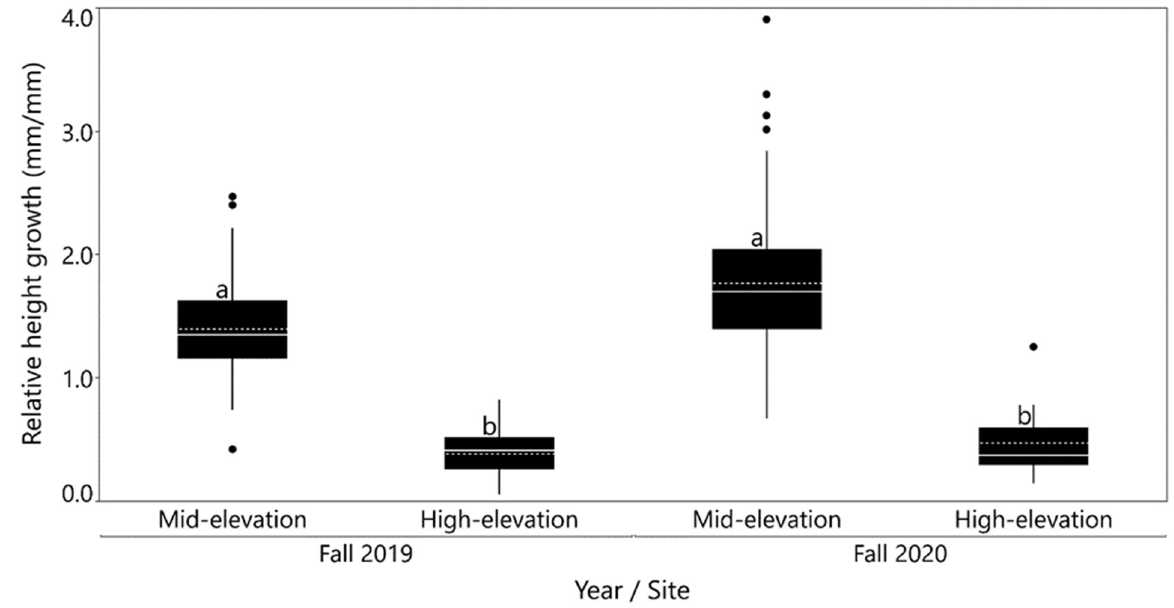
Figure 4. Relative height growth by planting sites (pooled over provenances) for 2019 and 2020. Dashed lines are mean and solid lines are the median. Means followed by the same letter do not differ significantly (Tukey’s HSD tests; α = 0.05).